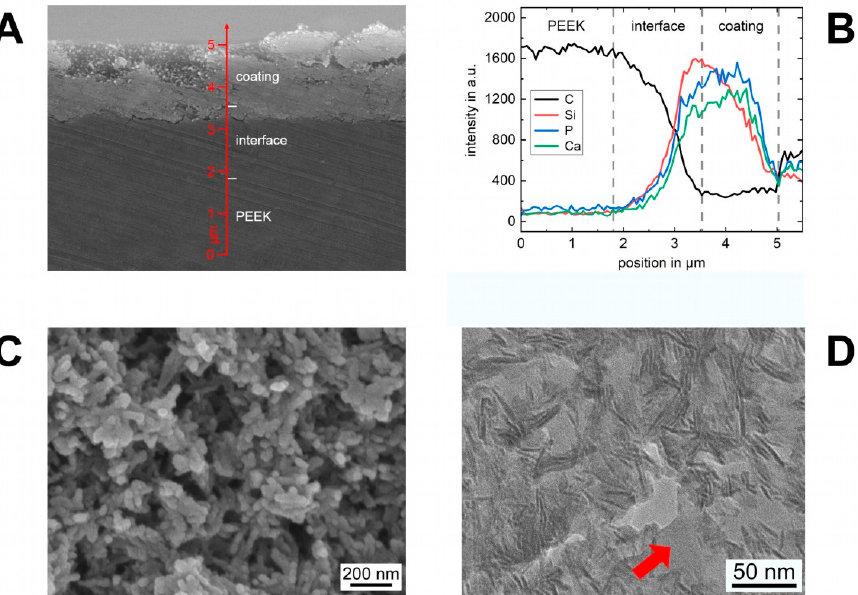
Figure 3. ( A ) SEM image of the cross-section of a coated and heat-treated implant. Three distinct areas are distinguishable: bulk PEEK, interface and coating material. ( B ) Chemical composition of the elements carbon, silicium, phosphor and calcium along the arrow in the SEM image ( A ). ( C ) SEM image of the nanostructure of the coating material with interconnecting pores. ( D ) TEM image of the interface cross-section. All pores of the coating material (darker contrast) are filled with PEEK (brighter contrast).